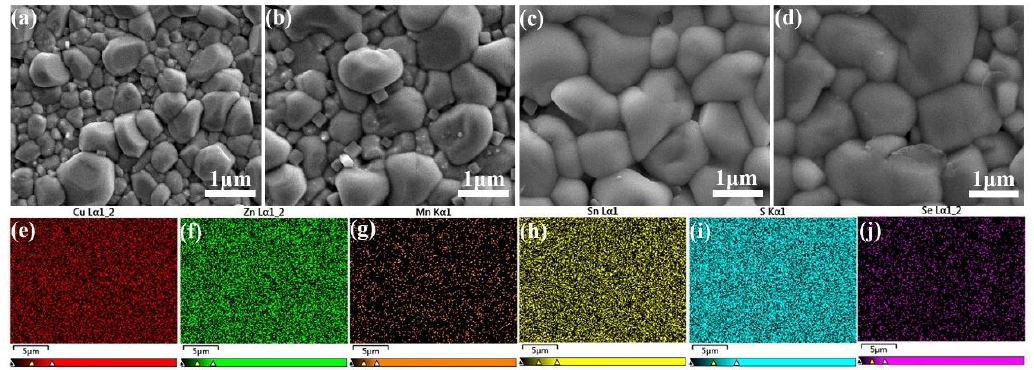
Figure 6. XPS spectra of CMZTSSe films annealed at 540 °C: ( a ) Cu 2p, ( b ) Zn 2p, ( c ) Mn 2p, ( d ) Sn 3d, ( e ) S2p, and ( f ) Se 3d.